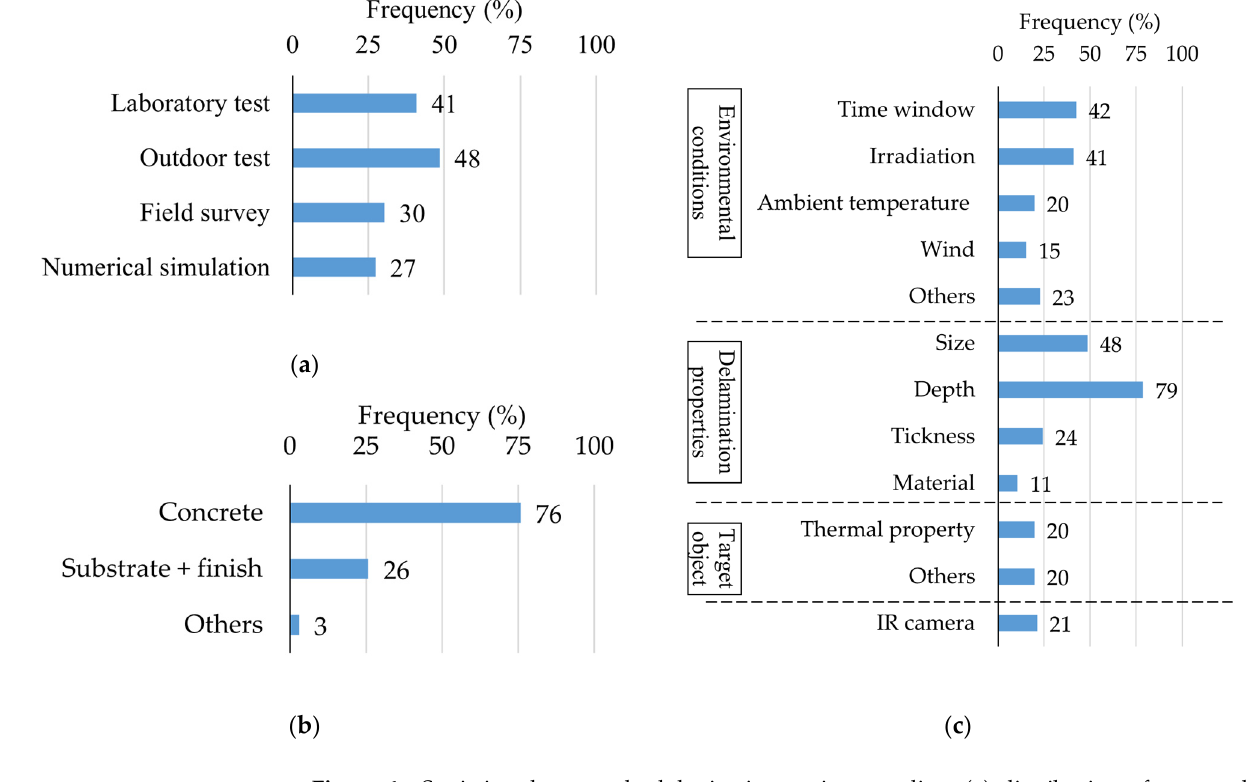
Figure 4. Statistics about methodologies in previous studies: ( a ) distribution of test methods; ( b ) distribution of target objects; ( c ) distribution of study factors.